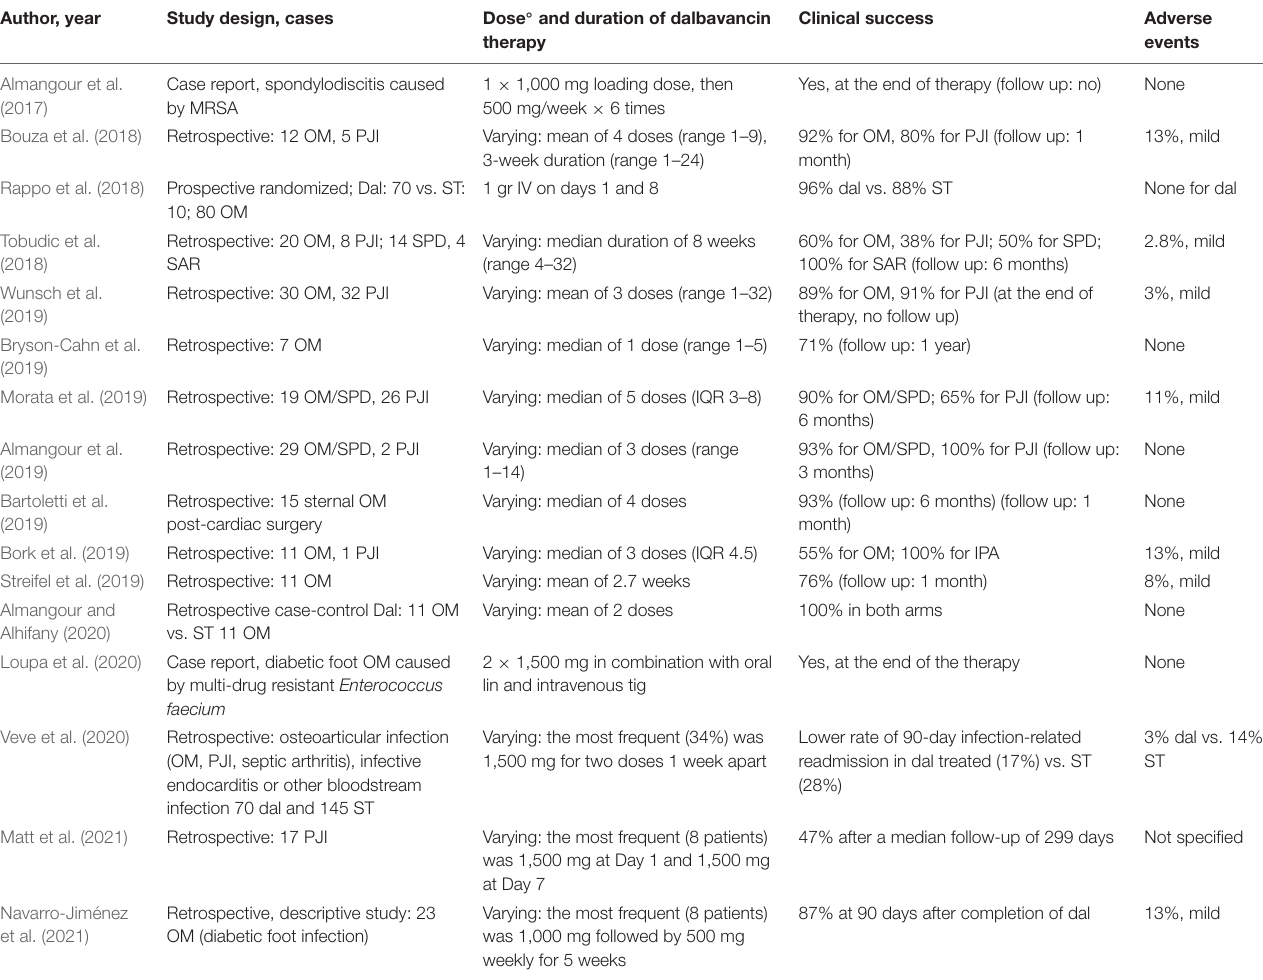
TABLE 2 | Dalbavancin in the treatment of bone and joint infections: an analysis of the